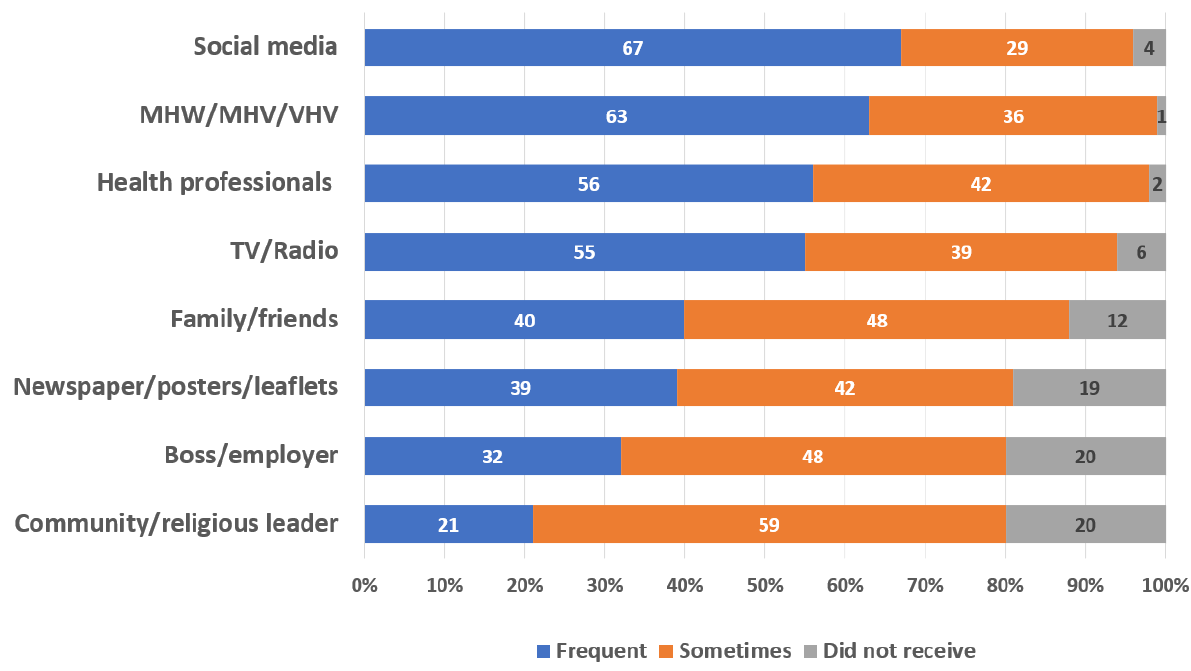
Figure 1. Proportion and frequency of health information received based on communication channels: MHW, migrant health worker; MHV, migrant health volunteer; VHV, village health volunteer.